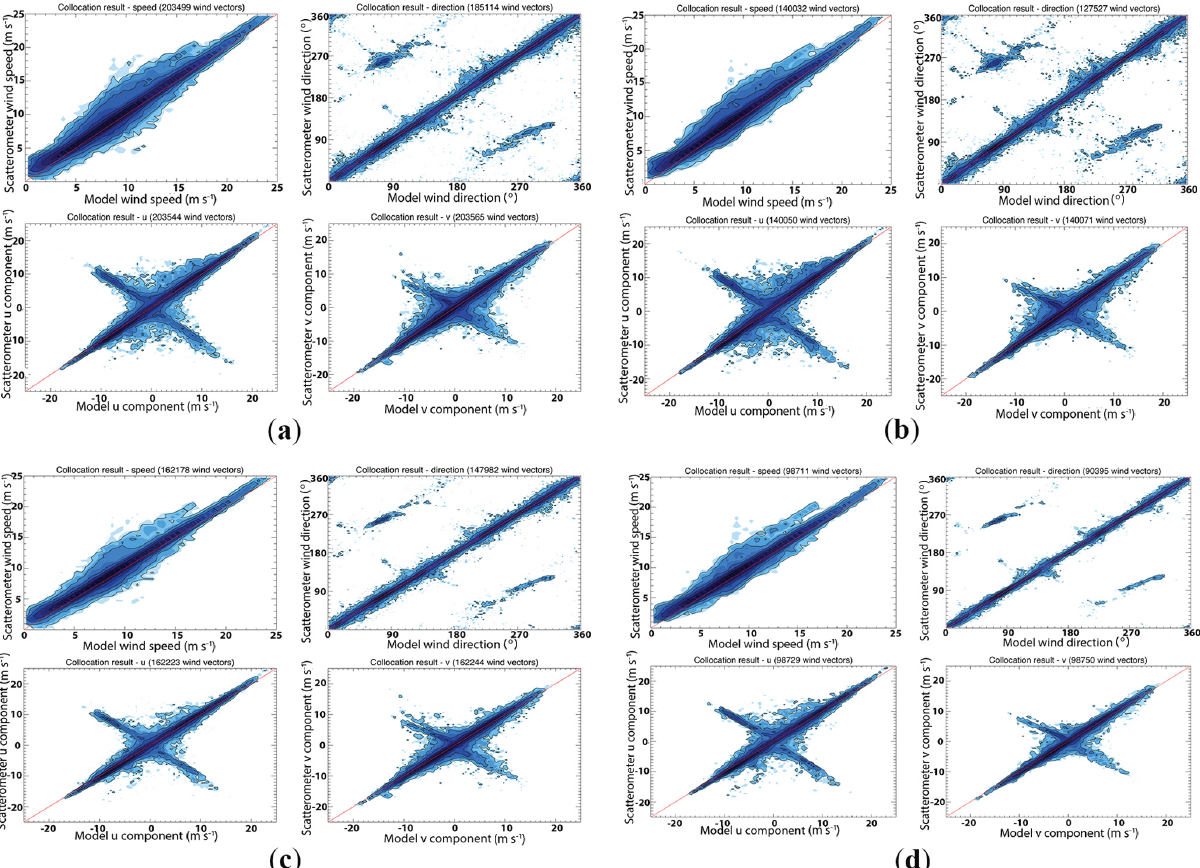
Figure 18. Contoured histograms of WindRad retrieved first rank wind solution versus input wind field for four orbits. (a) All WVCs within the swath; (b) excluding the WVCs in the outer swath, for which WVC numbers from 20 to 60 are included; (c) excluding the WVCs in the nadir swath, for which WVC numbers from 35 to 45 are included; (d) excluding the WVCs in the outer swath and nadir swath, for which WVC numbers from 20 to 35 and 45 to 60 are included. The four panels in (a)–(d) , upper left: wind speed; upper right: wind direction; lower left: u component; lower right: v component. The contour lines are